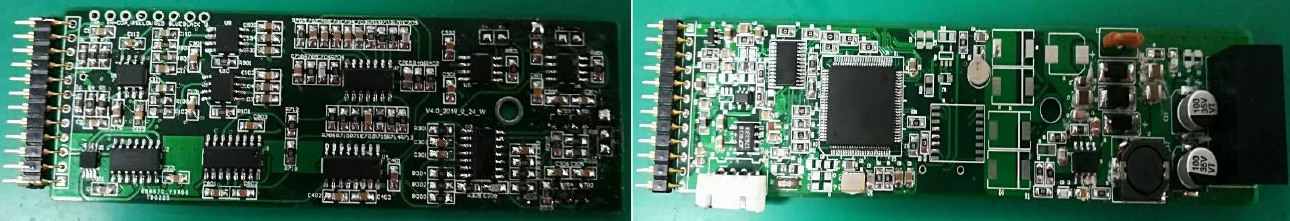
Figure 11. Repeatability test in still water. Table 1. Hydrostatic velocity repeatability test (cm/s). No.